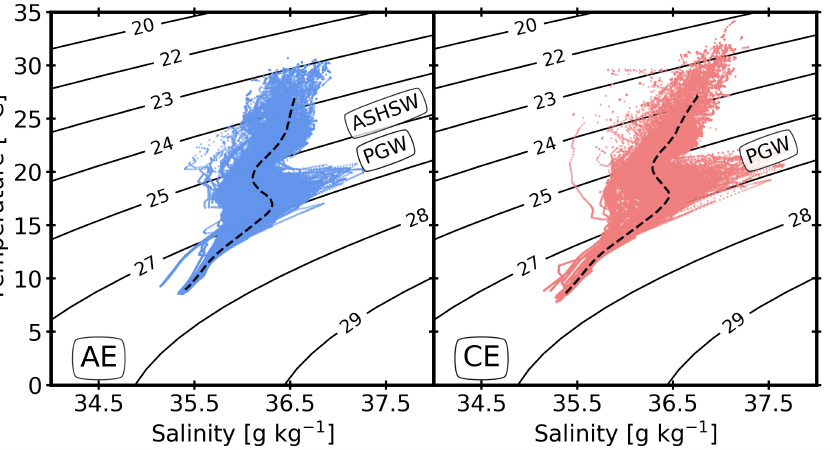
Figure 4. TS-diagram of the RAH dipole located in the NAS area for the CE and AC, bold solid lines are iso-density lines, the PGW signature is found in the CE and both PGW and ASHSW in the